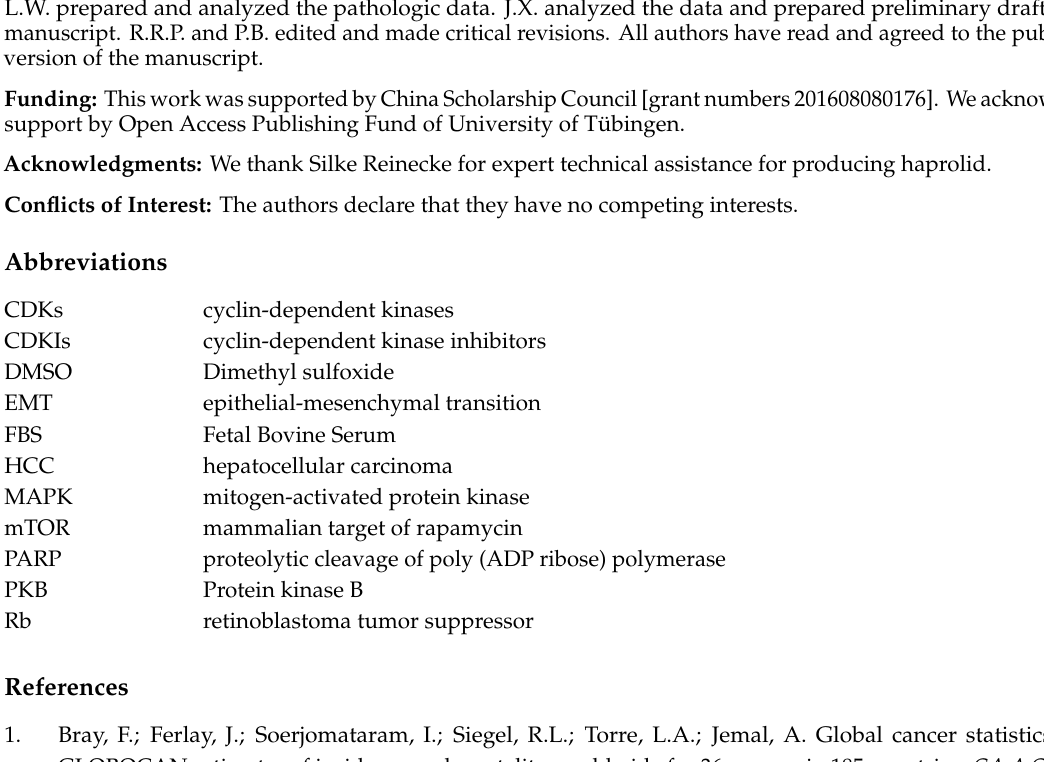
Table S1: The percentages of the cell cycle distribution across the sub-G1-, G1-, S- and G2-M-phases in control and haprolid-treated HCC cells, Figure S1: Di ff erential cytotoxicity between HCC cells and human fibroblast cells, Figure S2: Apoptotic e ff ect of haprolid on Huh-7 cells, Figure S3: Apoptotic e ff ect of haprolid on HepG2 cells, Figure S4: Evaluation of side e ff ects of haprolid in mice, Figure S5: Haprolid-induced degradation of Akt protein is neither proteasome nor caspase dependent and Erk phosphorylation is significantly increased by haprolid